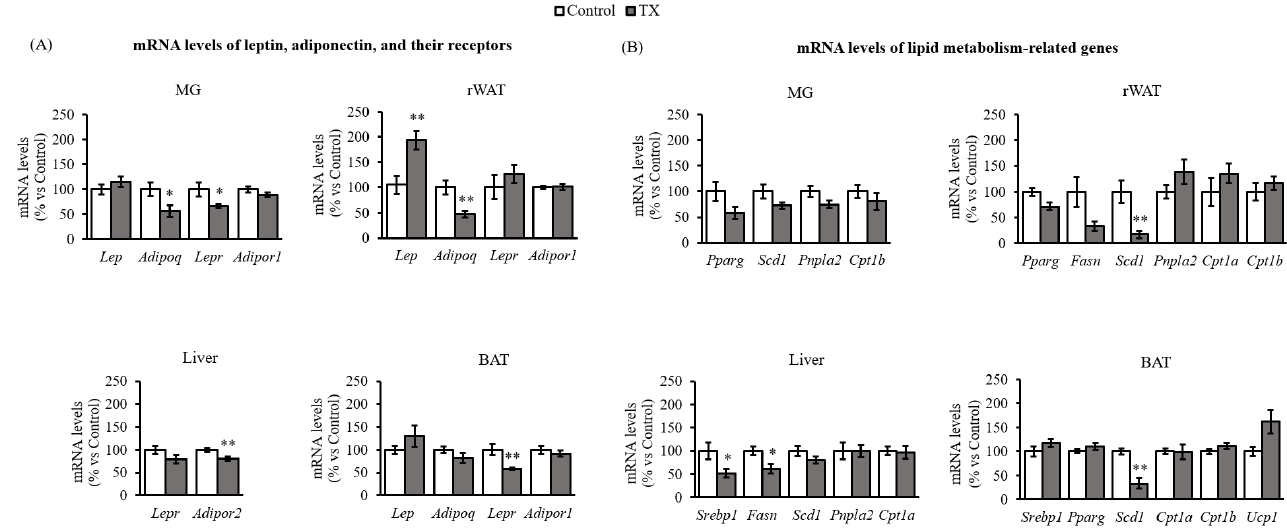
Figure 4. mRNA levels of leptin, adiponectin, and their receptors ( A ), and lipid metabolism-related genes ( B ) in MG, rWAT, liver, and BAT at the end of lactation. Data are mean ± SEM ( n = 7). Results are expressed relative to the gene expression value of the controls for each gene. Single comparisons between groups were performed by Student’s t -test: *, different from controls. Threshold significance was set at p ≤ 0.05 (**, p ≤ 0.00). Abbreviations: leptin ( Lep ), adiponectin ( Adipoq ), leptin receptor ( Lepr ), adiponectin receptor (Adipor ), peroxisome proliferator activated receptor gamma ( Pparg ), stearoyl-CoA desaturase-1 ( Scd1 ), patatin-like phospholipase domain-containing protein 2 ( Pnpla2 ), carnitine palmitoyltransferase 1 ( Cpt1 ), fatty acid synthase ( Fasn ), sterol regulatory element binding protein 1 ( Srebp1 ), uncoupling protein 1 ( Ucp1 ).